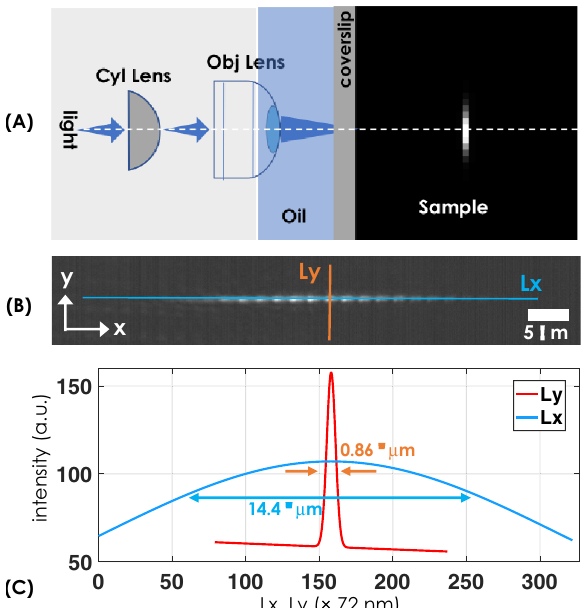
Figure 2. ( A ) Schematic diagram showing the formation of lightsheet point spread function (PSF) inside the specimen. This is realized by a combination of cylindrical lens and the oil immersion high NA objective lens. ( B ) The reflected image of lightsheet formed in the cell medium (cell medium) as observed by the camera. ( C ) Gaussian fit for the intensity across the light sheet (blue and orange line), shows the actual size of lightsheet to be 0.86 µ m × 14.4 µ m ( y × x